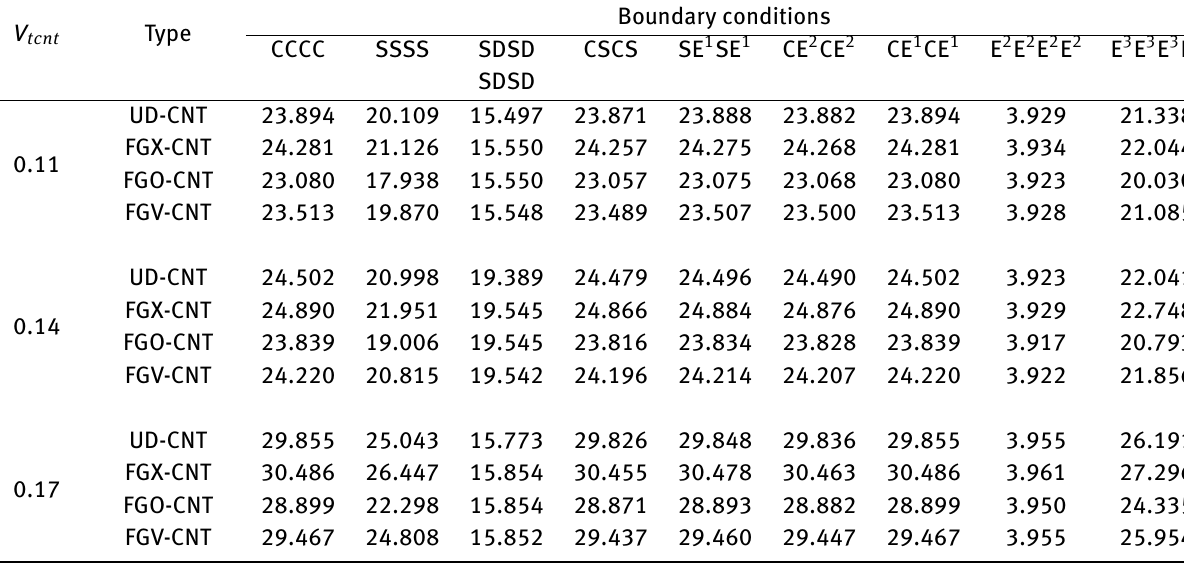
Table 8: Fundamental frequency parameters Ω for FG-CNT reinforced composite annular sector plates with different boundary conditions